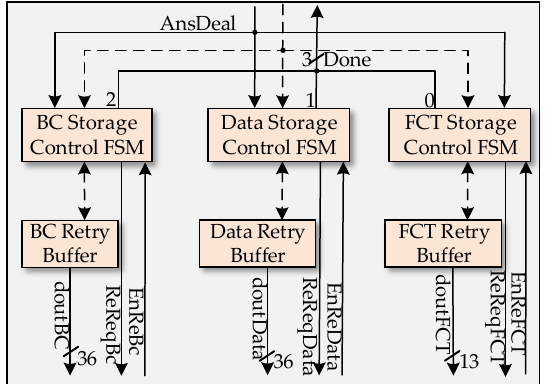
Figure 4. Block diagram of the storage control level.